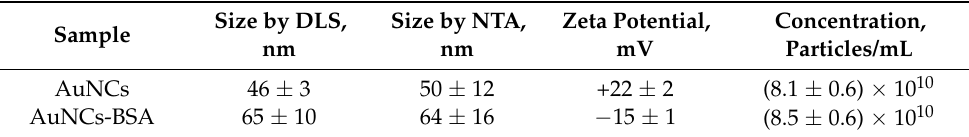
Table 1. The characterization of nanoparticles by dynamic light scattering (DLS) and nanoparticles tracking analysis